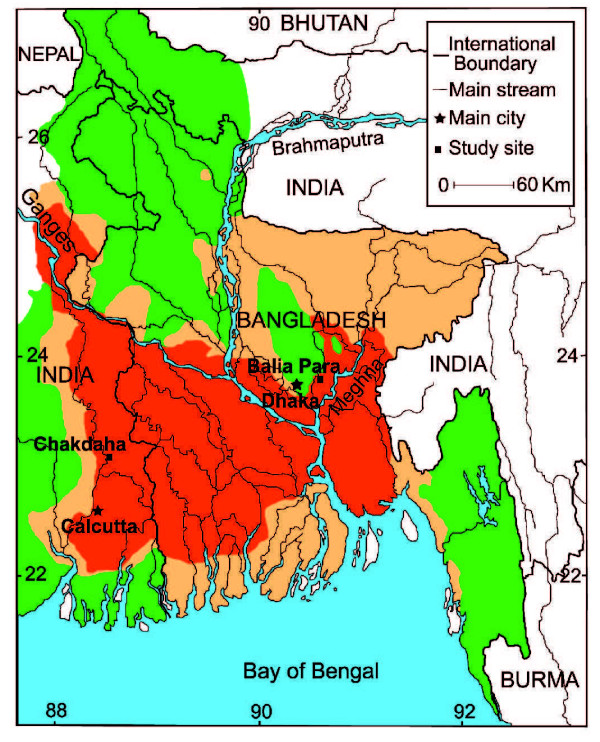
Map of the entire Bengal Basin showing the general distribution of As in tubewells on the basis of data collected by Dr. Chakraborti's laboratory at the School of Environmental Studies, Jadavpur University, Kolkata, India. Most tubewells contain >50 μg L-1 arsenic in red areas and <50 μg L-1 in green areas. Orange areas indicate a mixed distribution high- and low-As well. Also shown are the location of the two study sites and the two largest cities in the region. Adapted from [9].